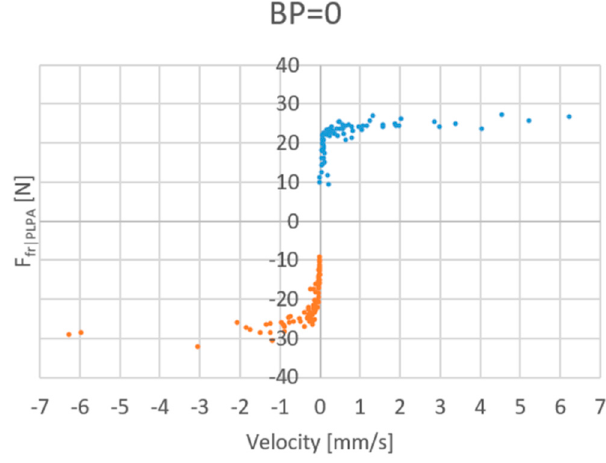
= 0 bar, around zero Figure 14. Viscous 𝐹 (cid:3033)(cid:3045)|(cid:3017)(cid:3013)(cid:3017)(cid:3002) force with BP = 0 bar, around zero velocity. Figure 14. Viscous F fr | PLPA force with BP Figure 14. Viscous 𝐹 (cid:3033)(cid:3045)|(cid:3017)(cid:3013)(cid:3017)(cid:3002) force with BP = 0 bar, around zero velocity.